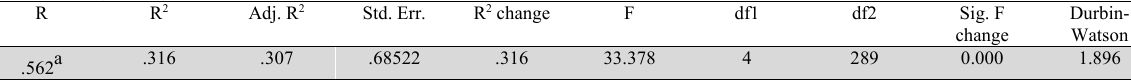
The summary model